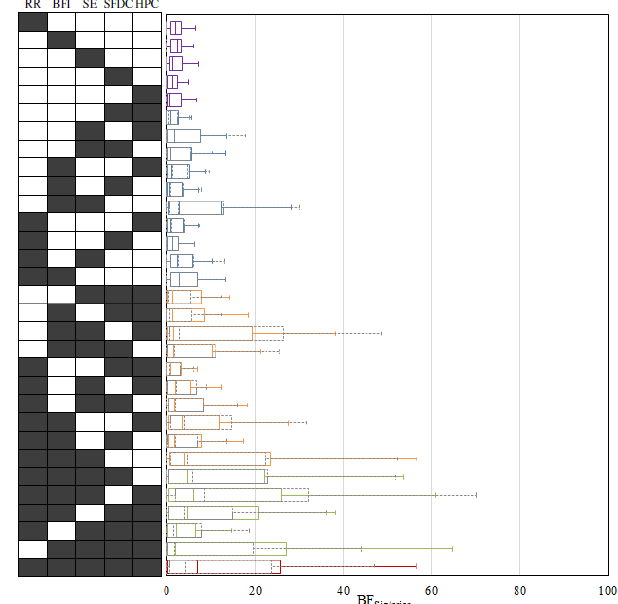
Figure 5. Boxplots representing the distribution of the Bayes factor for each combination of signatures for observed streamflow data. The colored boxplots correspond to the results obtained when inter- signature error correlations are considered in the likelihood func- tion, whereas the grey dashed boxplots correspond to the results obtained assuming that the inter-signature errors are